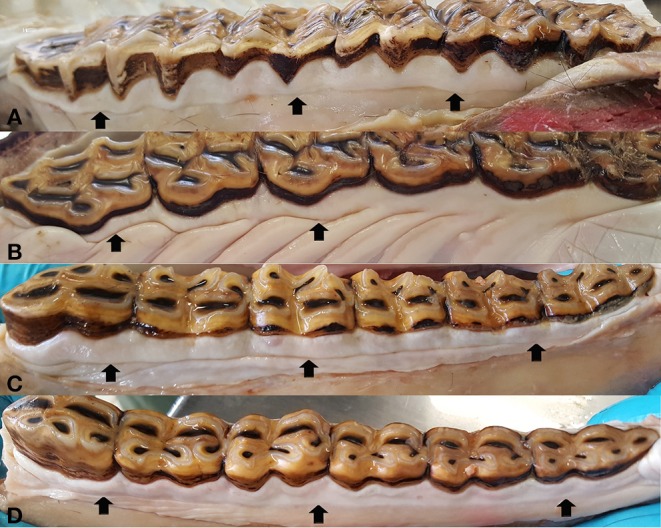
Mucogingival junction (arrows) in the cheek teeth, represented by an almost straight line in the buccal aspect of the upper cheek teeth (A), buccal (C), and lingual (D) aspect of the lower cheek teeth. In the palatal aspect of the upper cheek teeth (B), the mucogingival junction fuses with the rugae palatinae.